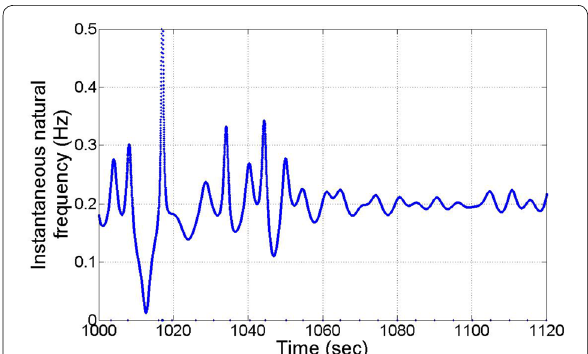
Fig. 18 Instantaneous natural frequency of mode 1.